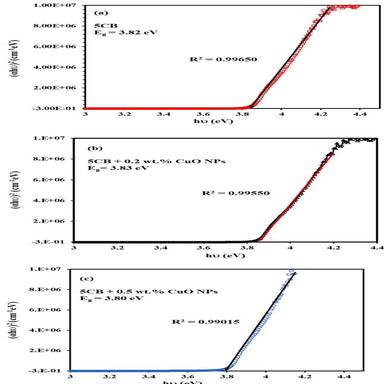
Tauc plots for the estimation of the band gap (Eg) (a) 5CB (b) 5CB + 0.2 wt% CuO NPs (c) 5CB + 0.5 wt%. Arrows indicate Eg.